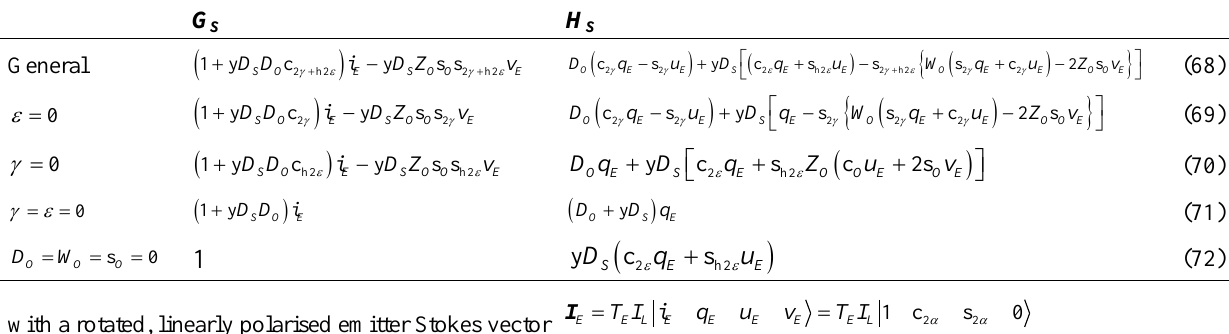
and H and their simplifications when neglecting some uncertainties for the case of Eq. (56), i.e. S S